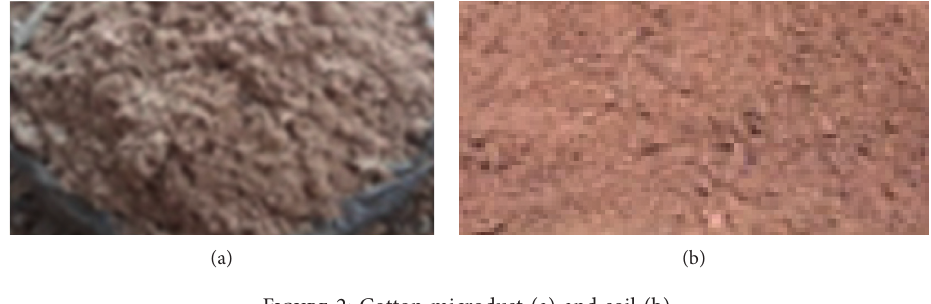
Figure 2: Cotton microdust (a) and soil (b).